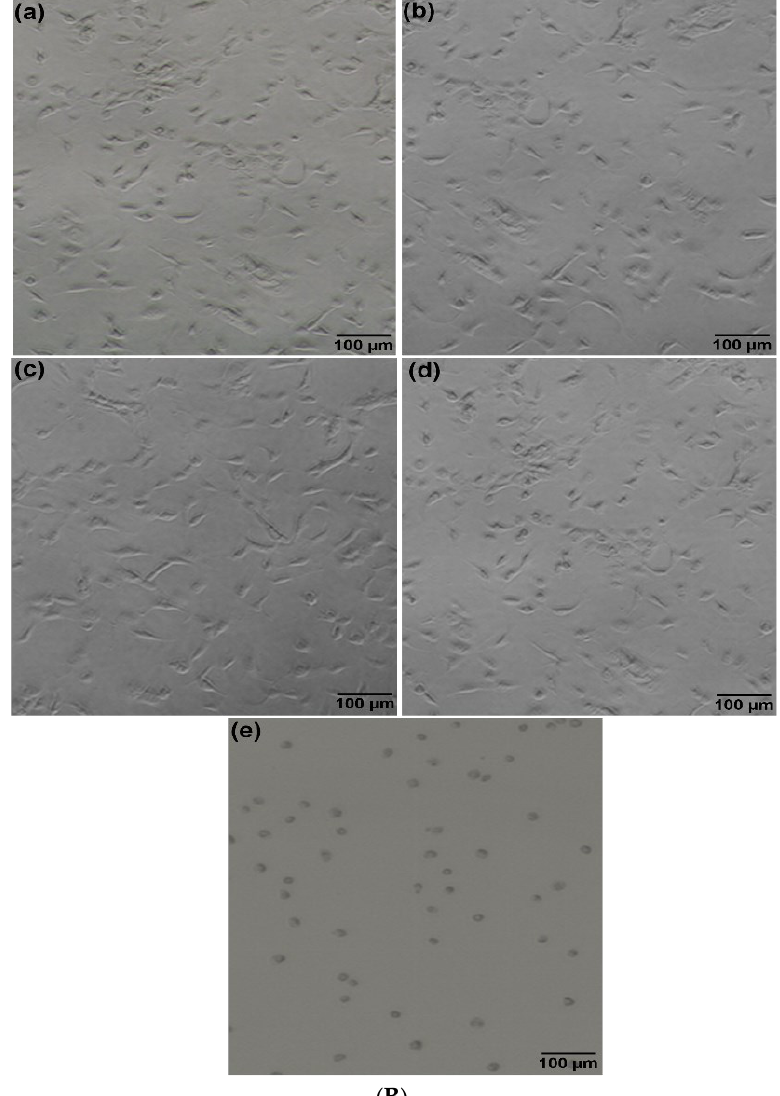
Figure 9. ( A ) Phase contrast morphology of RAW 264.7 murine macrophage cell visualized by inverted microscope (×10 magnification). The cells were treated with 30 μ g/mL of Control ( a ), PZQ ( b ), NLP ( c ), anti-calpain-NLP ( d ), and 5-FU ( e ). ( B ) Phase contrast morphology of 3T3 human fibroblast cell visualized by inverted microscope (×10 magnification). The cells were treated with 30 μ g/mL of Control ( a ), PZQ ( b ), NLP ( c ), anti-calpain-NLP ( d ), and 5-FU ( e ).